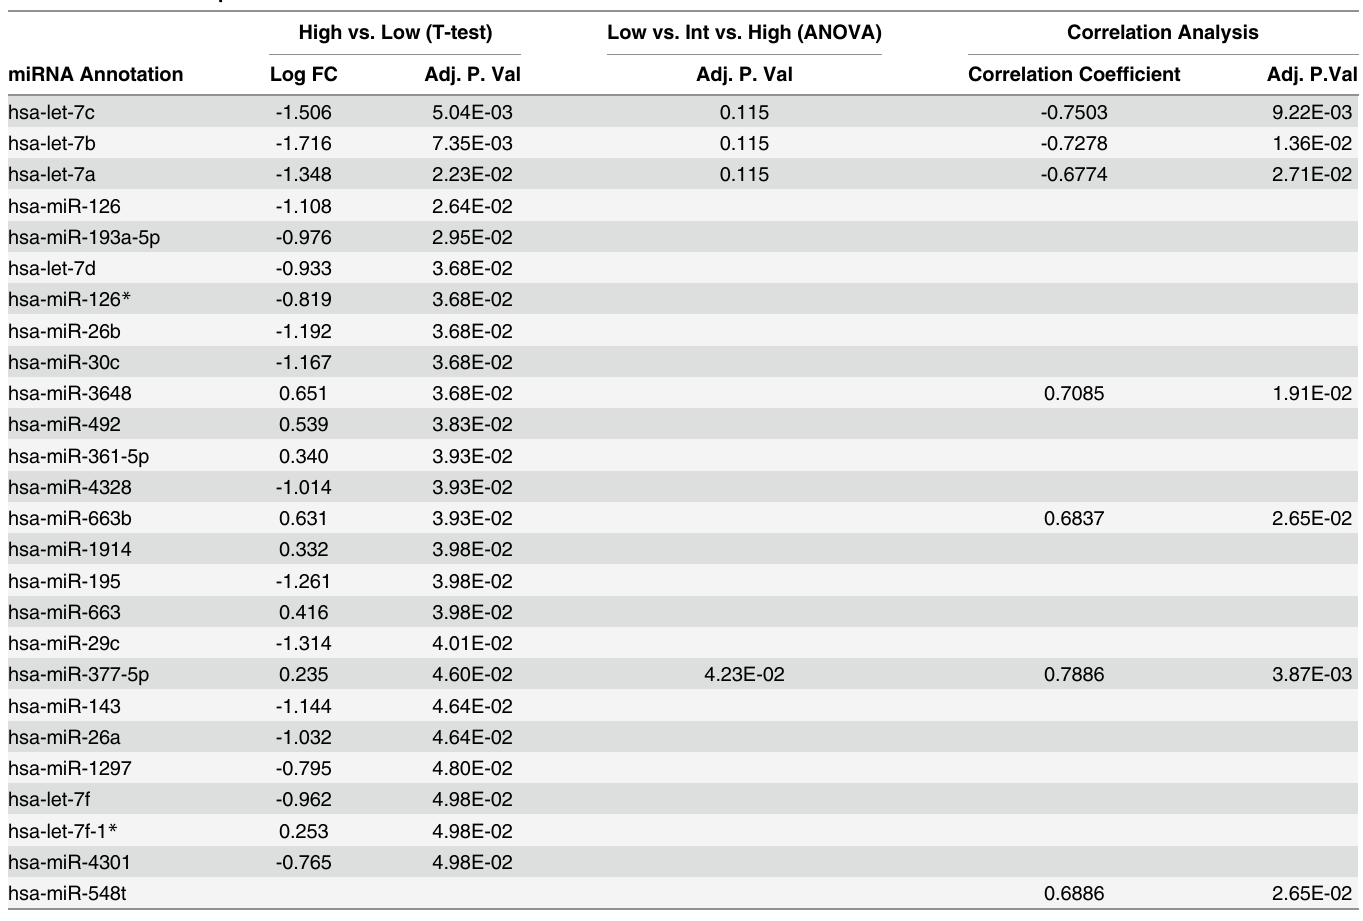
Table 2. Differential expression of miRNAs.